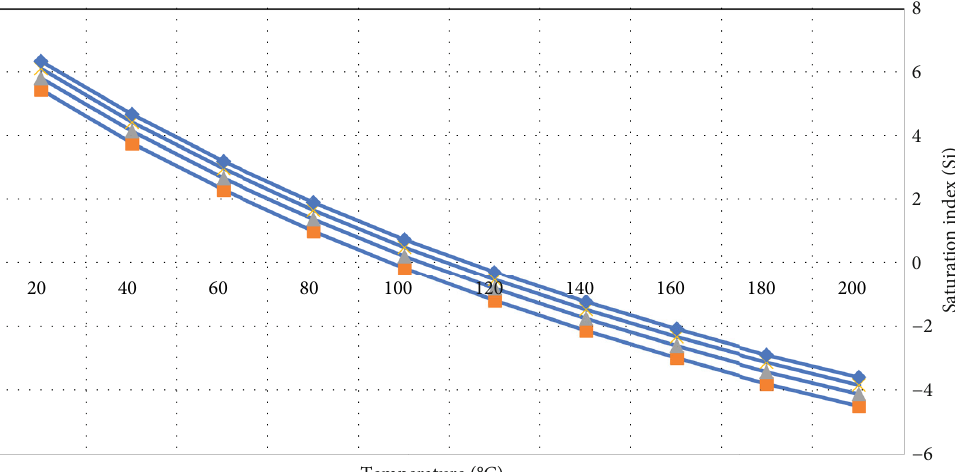
Figure 5: Changes in the state of stibnite in geothermal fl uid.